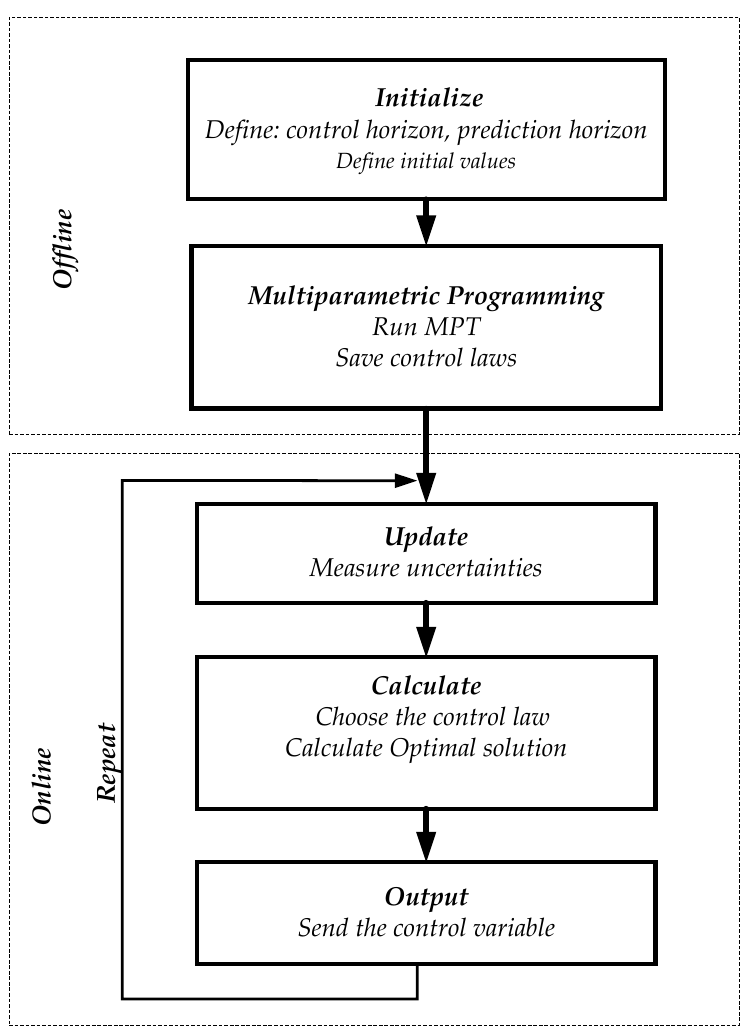
Figure 11. Block diagram of multiparametric programming